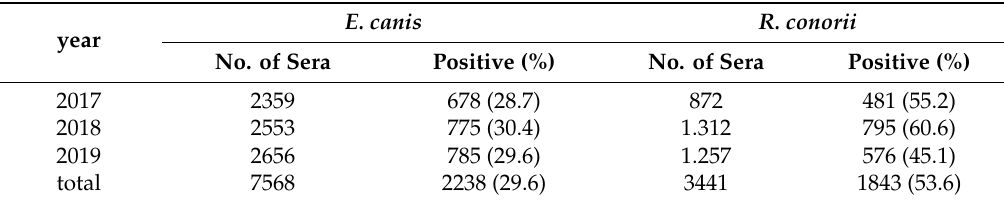
Table 2. Seroprevalence of E. canis and R. conorii among tested sera in relationship to annual variation. E. year